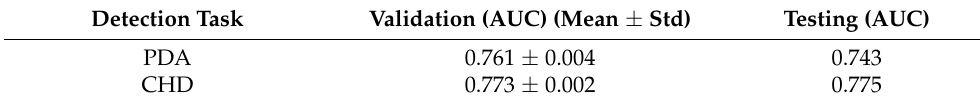
Table 8. The comparison of performance for PDA vs. healthy model and CHD vs. healthy model. Detection Task